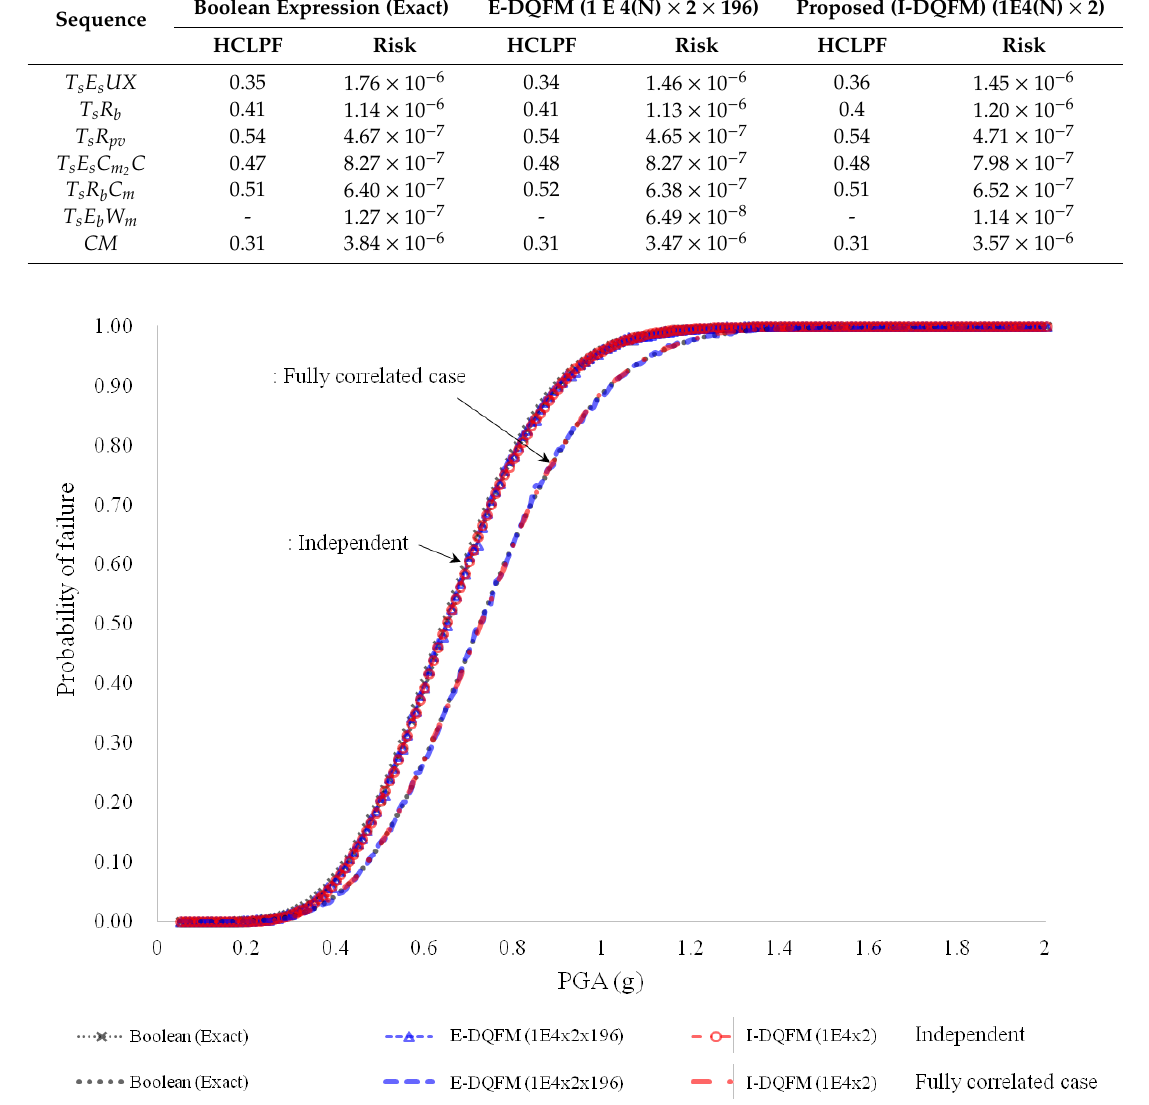
Figure 13. The impact of these hazard correlations in the risk calculations cannot be taken into Table 5. Mean seismic risk for “LGS NPP”: Fully correlated case.